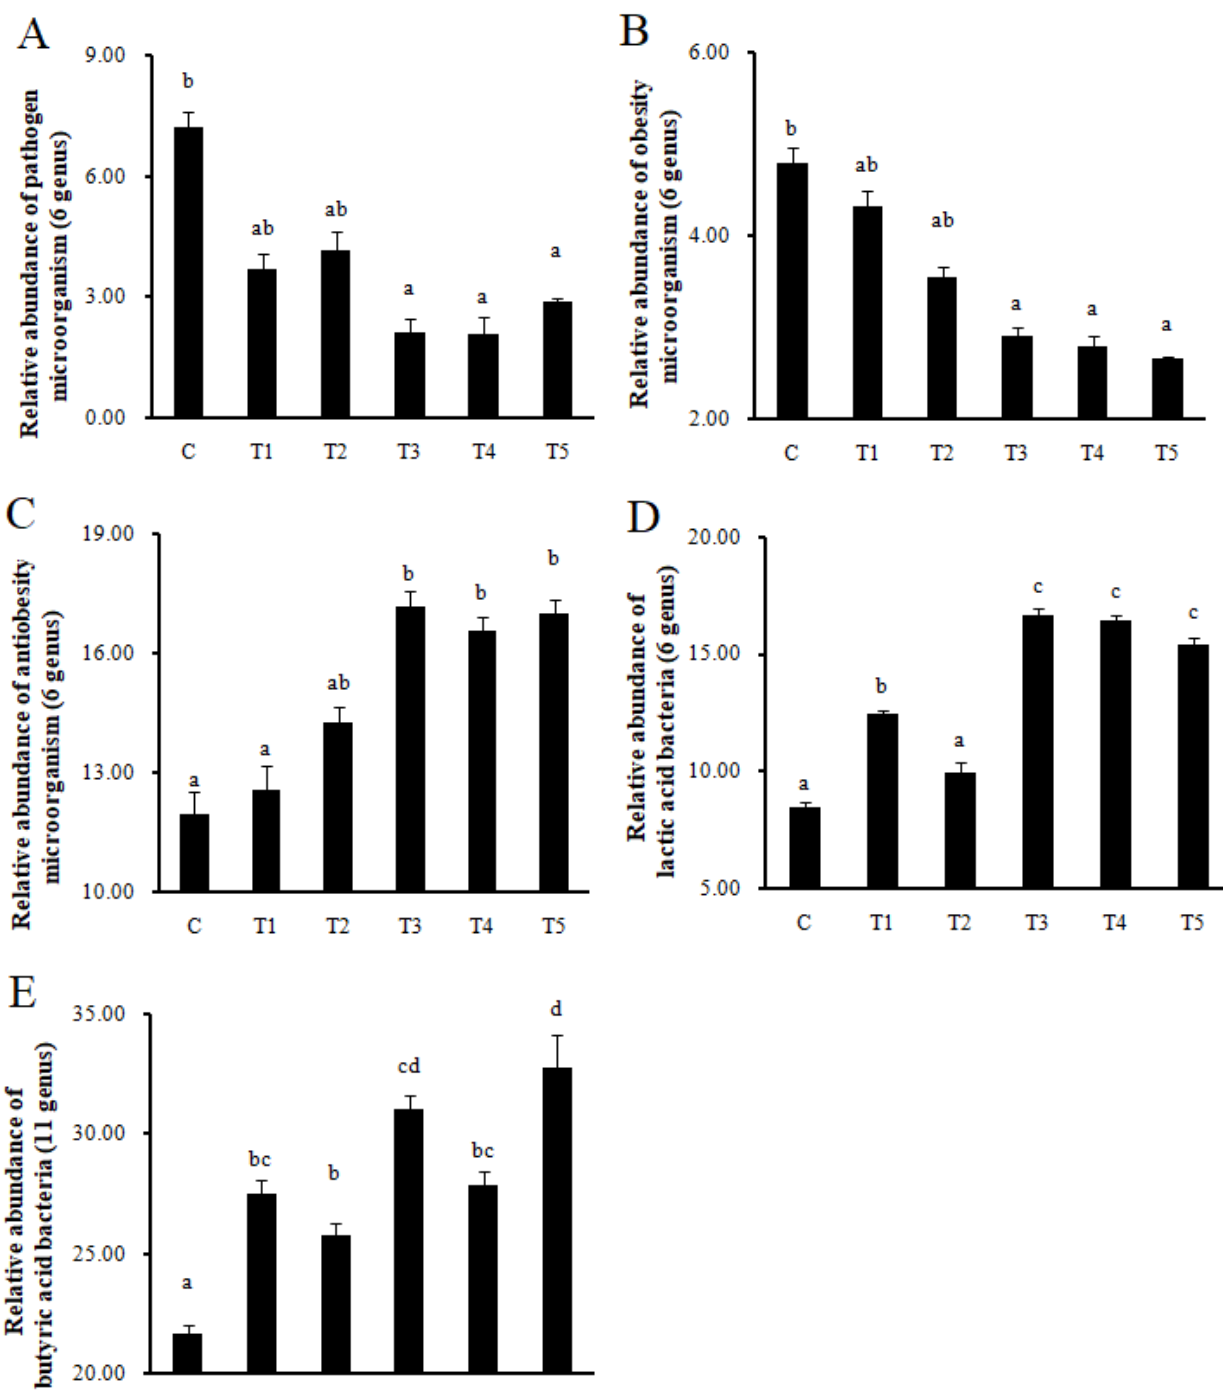
Figure 5. Comparison of the relative abundance in 6 types of pathogen bacteria, 6 types of obesity bacteria, 6 types of antiobesity bacteria, 6 types of lactic acid bacteria and 11 types of butyric acid bacteria in the gut microbiota composition by next generation sequencing (Illumina MiSeq; Chunlab Inc., Seoul, Korea). C, control; T1, 1% RC -LAB fermented feed; T2, 2% RC -LAB fermented feed; T3, 2% L. plantarum ; T4, 2% L. acidophilus ; T5, 2% B. ani- malis . (A) 6 types of pathogen bacteria ( Clostridium , Bacteroides , Prevotella , Mollicutes , Porphyromonas , Campylobacter ); and (B) 6 types of obesity bacteria ( Roseburia , Oscillibacter , Mollicutes , Coprobacillus , Allobaculum , Faecalibaculum ); and (C) 6 types of antiobesity bacteria ( Prevotella , Alistipes , Bacteroides , Prevotellaceae , Bacteroides , Parabacteroides ); and (D) 6 types of lactic acid bacteria ( Lactobacillus , Subdoligranulum , Streptococcus , Bi- fidobacterium , Enterococcus , Pediococcus ); and (E) 11 types of butyric acid bacteria ( Eisenbergiella , Propionibacterium , Eubacterium , Pseudoflavoni - fractor , Ruminococcus , Roseburia , Butyricicoccus , Coprococcus , Subdoligranulum , Fusobacterium , Butyrivibrio ). RC -LAB, Rubus coreanus -derived lactic acid bacteria. Data represent means±standard deviations of 8 replicates. a-d Means are significantly different within the same row